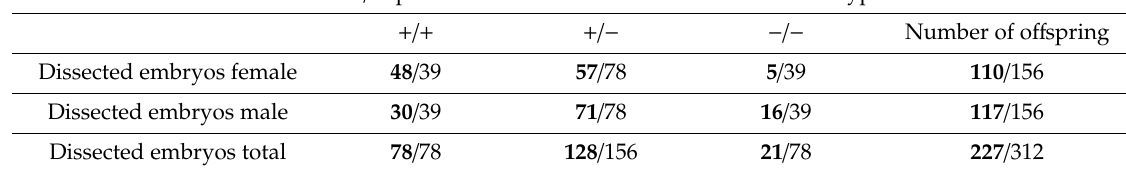
Table 2. Embryonic day E11-20 genotype distribution for o ff spring from Atxn2l +/ − intercrosses. Most lethality occurred before E11, with females dying before males.